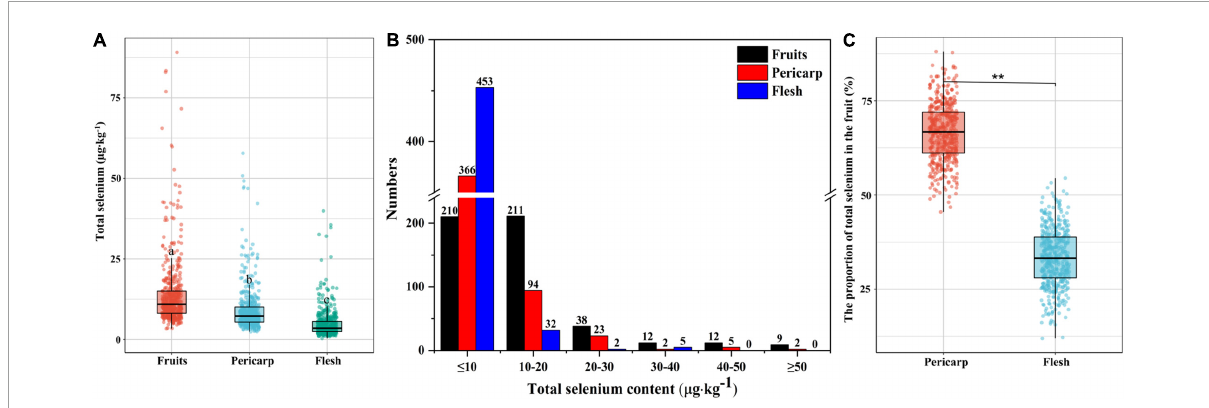
FIGURE2 Total Se content of navel orange fruit, pericarp, and flesh in southern Jiangxi (A) , distribution of total Se content in fruit (B) , and percentage of total Se in flesh and pericarp ( n = 492) (C) . Letters indicate a significant difference at p < 0.05 among treatments (** p < 0.01).